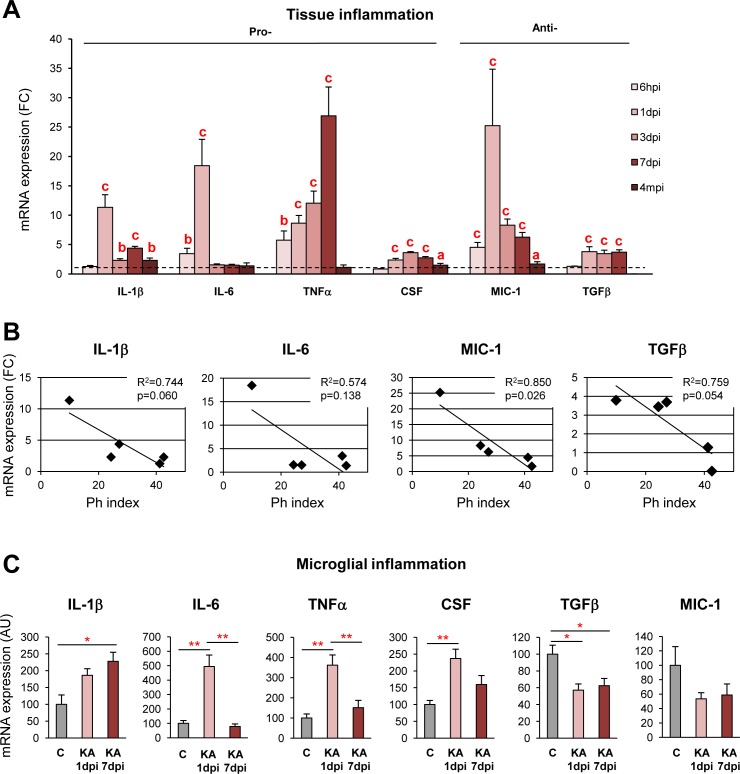
Phagocytosis impairment correlates with inflammation in mouse MTLE.(A) RTqPCR quantification of a panel of pro- and anti-inflammatory cytokines in the hippocampus of mice injected with saline or KA over a time course. Expression was normalized with the reference gene L27A and expressed as fold change (FC) over the saline injected mice (dashed line). The expression of the cytokines was linearized by a logarithmic transformation; only significant interactions are shown. (B) Linear regression analysis of the relationship between the average expression of tissue cytokines (IL-1β, IL-6, MIC, TGFβ) and average Ph index in KA-injected mice along the time course. The Ph index explained a large percentage of the variation of the expression of these cytokines, although significance at p = 0.05 was only reached for MIC-1 likely due to the small number of time points analyzed. (C) RTqPCR quantification of a panel of pro- and anti-inflammatory cytokines in FACS-sorted fms-EGFP+ microglia. In A and C data are shown as mean ± SEM. a, * indicates p < 0.05; b, ** indicates p < 0.01; and c,*** indicates p < 0.001 by Holm-Sidak posthoc test compared to their respective time point controls, after one-way ANOVA was significant at p < 0.05. Underlying data is shown in S1 Data.